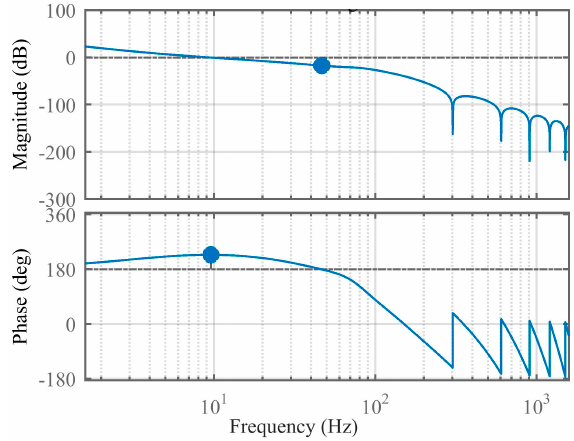
Figure 14. Open-loop bode plot of the proposed PLL.